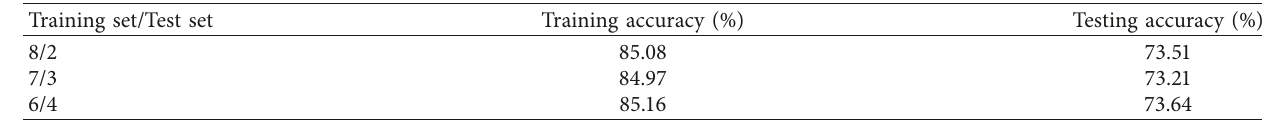
Figure 1: Risk classification. Table 9: Financial risk warning training and